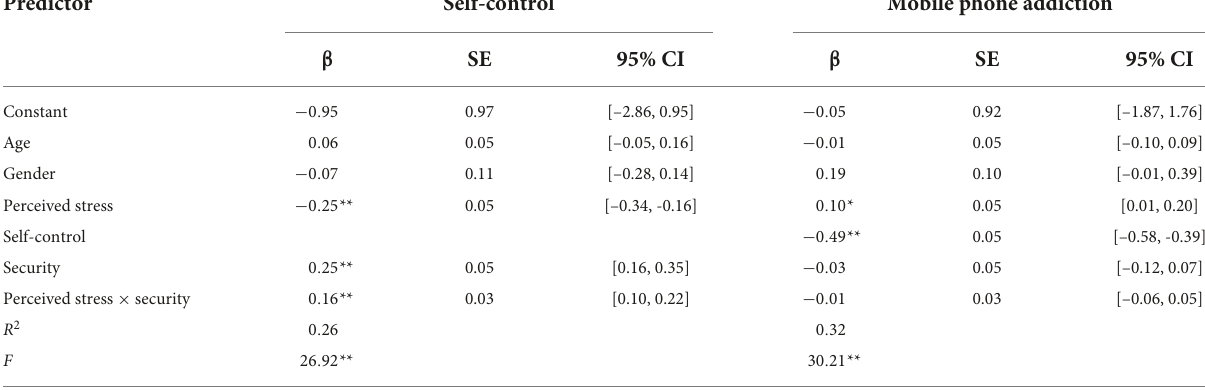
TABLE 4 Summary of moderated mediation effect